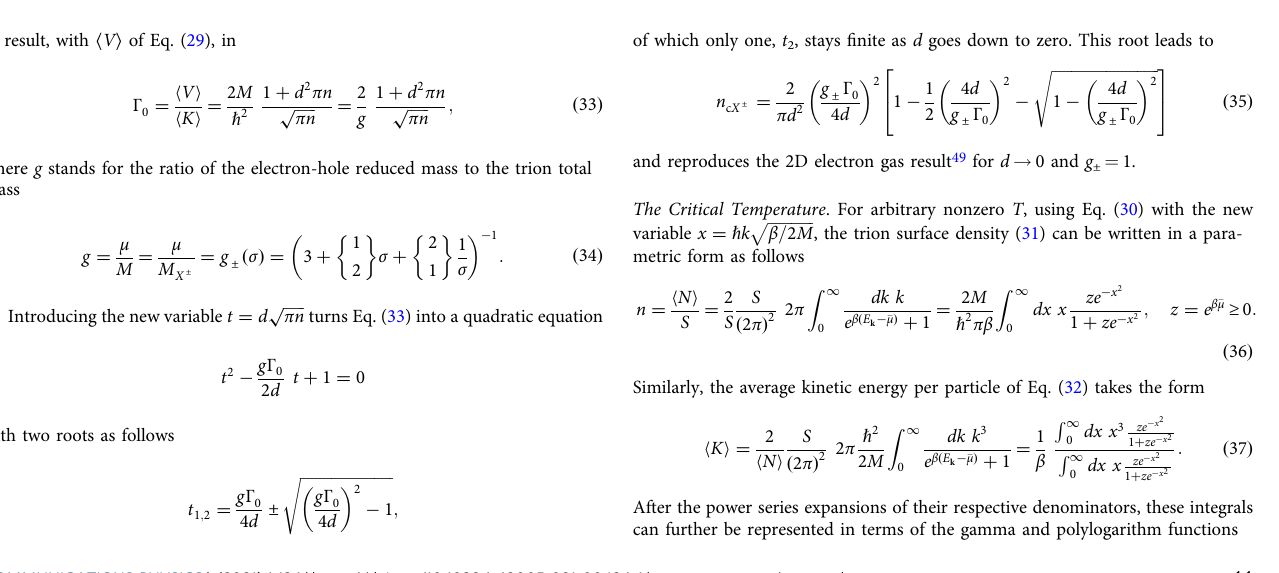
Fig. 7 Charged interlayer exciton pairwise interaction geometry. a , b The coplanar pairwise interaction geometry for the unlike-charge and like-charge interlayer trion complexes, respectively, in a bilayer of the interlayer separation d . Here, R is the trion-trion center-of-mass-to-center-of-mass distance and r fi rst and second trion of the interacting trion pair. By the triangle similarity theorem distances r 1,2 are the distances between the like charges in the are related to the equilibrium center-of-mass-to-center-of-mass distance Δ ρ X ± of the two equivalent interlayer excitons (IEs) sharing the same electron (or hole) to form the charged interlayer exciton (CIE, trion). They can be different for the pairs of unlike-charge trions but they are always the same for like- charge trion pairs as shown in ( a ) and ( b ), respectively. c , d Top view of the parallel biplanar pairwise interaction geometry for the unlike-charge trion pair and the respective pairwise interaction potential energy W as given by Eq.